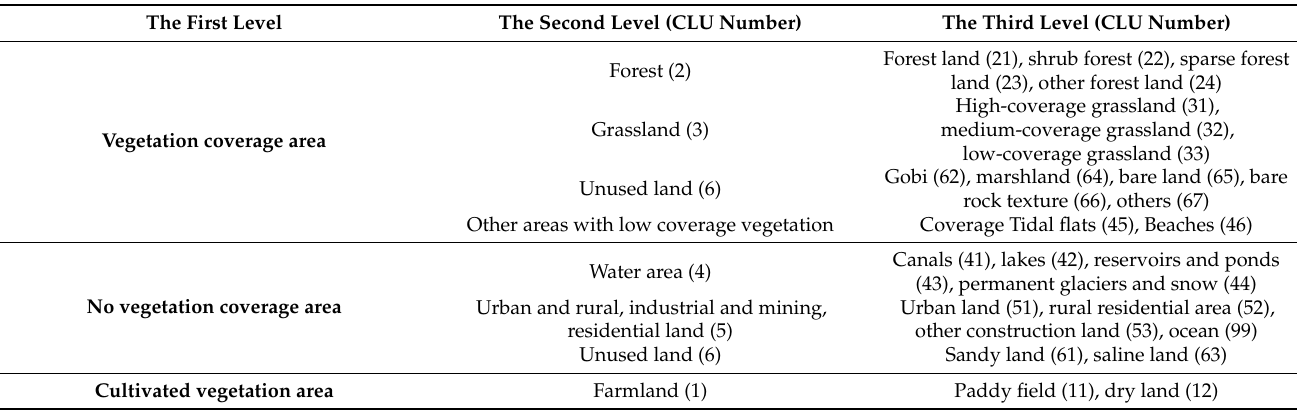
Table 3. Combination of LU remote sensing monitoring data classification system.